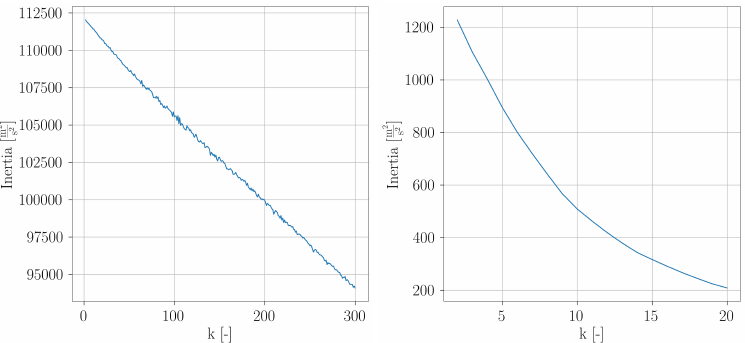
Figure 24. Relation between inertia and k for setup 1 ( left ) and setup 2 ( right